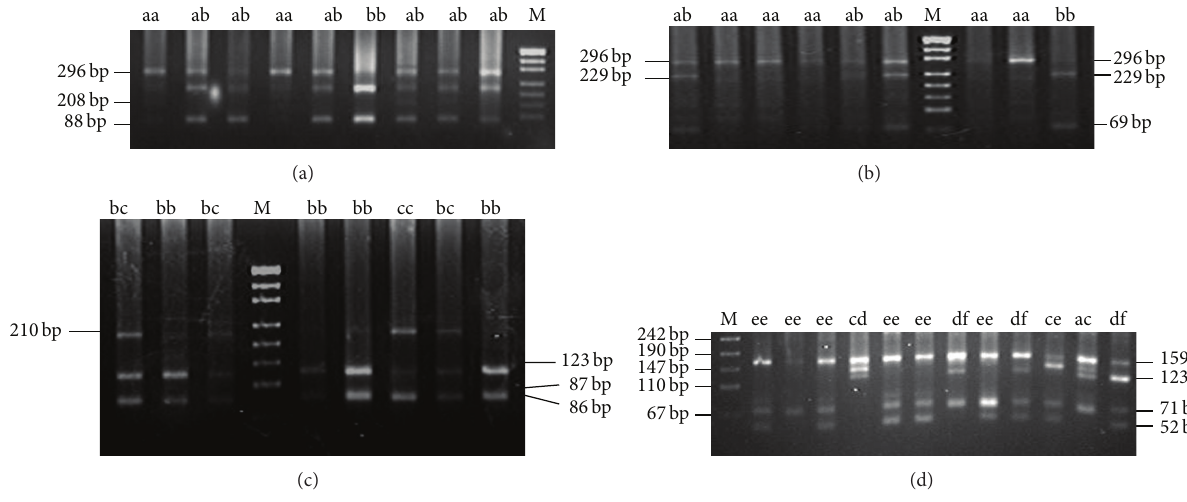
Figure 1: (a) Part results of electrophoretic patterns of exon 2 of MHC- DRB 1 digested with Sac I in Chinese Merino sheep; M: pUC19 DNA marker. (b) Part results of electrophoretic patterns of exon 2 of MHC- DRB 1 digested with Sac II in Chinese Merino sheep; M: pUC19 DNA marker. (c) Part results of electrophoretic patterns of exon 2 of MHC- DRB 1 digested with Mva I in Chinese Merino sheep; M: pUC19 DNA marker. (d) Part results of electrophoretic patterns of exon 2 of MHC- DRB 1 digested with Hae III in Chinese Merino sheep; M: pUC19 DNA